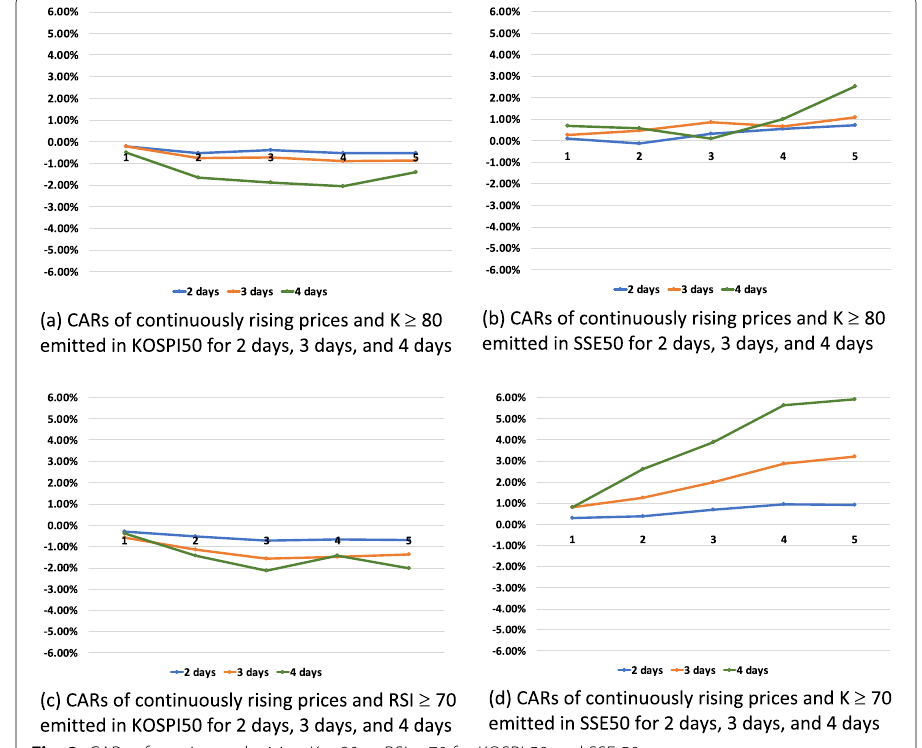
80 or RSI 70 for KOSPI 50 and SSE ≥ ≥